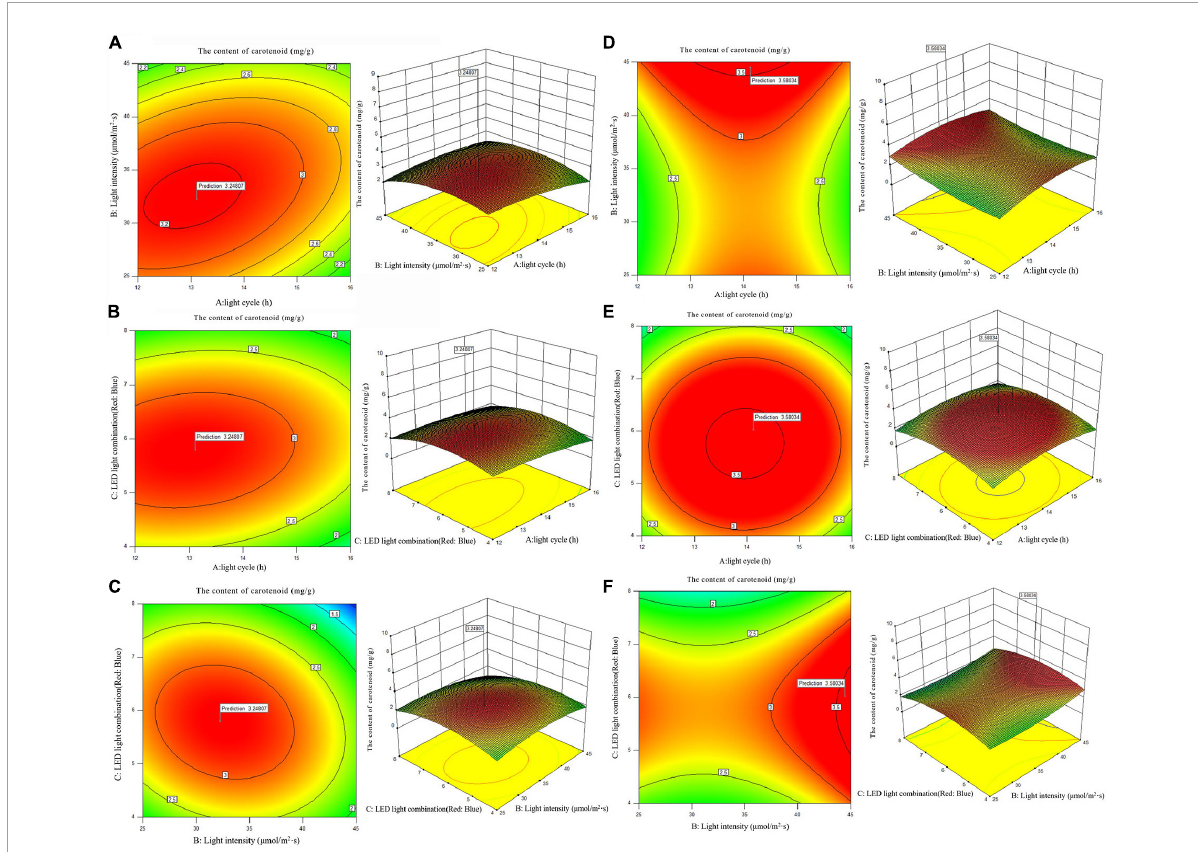
FIGURE4 2D contour diagram and 3D surface diagram of carotenoid content of Arthrospira platensis OUC623 and A. platensis OUC793. (A) Contour diagram and response surface diagram of carotenoid content of 623 with light time (12, 14, and 16 h) and light intensity (25, 35, and 45 µ mol/m 2 s) under the light of red6:blue 1. (B) Contour diagram and response surface diagram of carotenoid content of 623 with light time (12, 14, and 16 h) and red and blue light combination (red: blue = 4:1, 6:1, 8:1) under light intensity of 35 µ mol/m 2 s. (C) Contour diagram and response surface diagram of carotenoid content of 623 with red and blue light combination (red: blue = 4:1, 6:1, 8:1) and light intensity (25, 35, and 45 µ mol/m 2 s) under the light cycle of L14:D10. (D) Contour diagram and response surface diagram of carotenoid content of 793 with light time (12, 14, and 16 h) and light intensity (25, 35, and 45 µ mol/m 2 s) under the light of red6:blue 1. (E) Contour diagram and response surface diagram of carotenoid content of 793 with light time (12, 14, and 16 h) and red and blue light combination (red: blue = 4:1, 6:1, 8:1) under light intensity of 35 µ mol/m 2 s. (F) Contour diagram and response surface diagram of carotenoid content of 793 with red and blue light combination (red: blue = 4:1, 6:1, 8:1) and light intensity (25, 35, and 45 µ mol/m 2 s) under the light cycle of